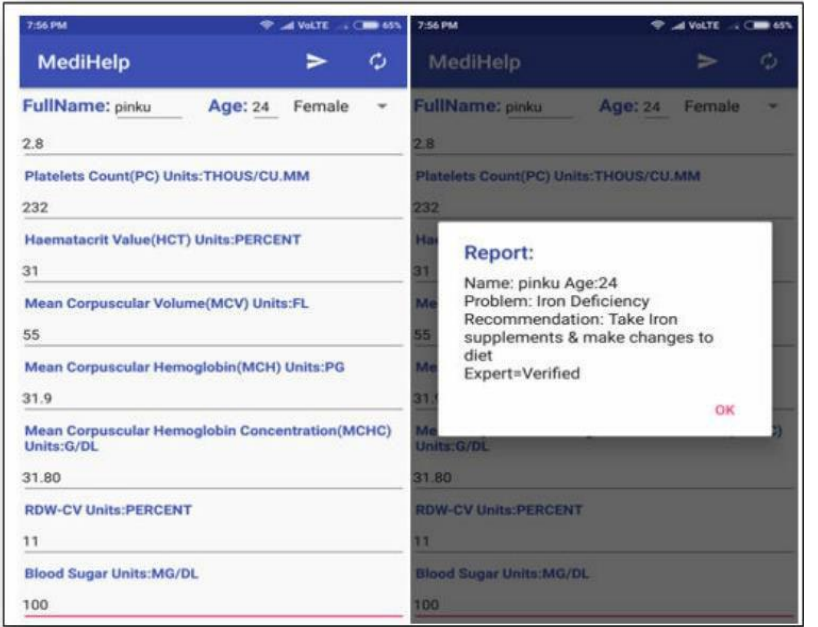
Figure 6. A user interface to fill in the details of user 1.